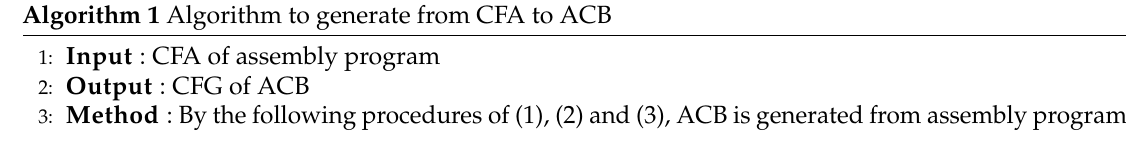
Algorithm 1 Algorithm to generate from CFA to